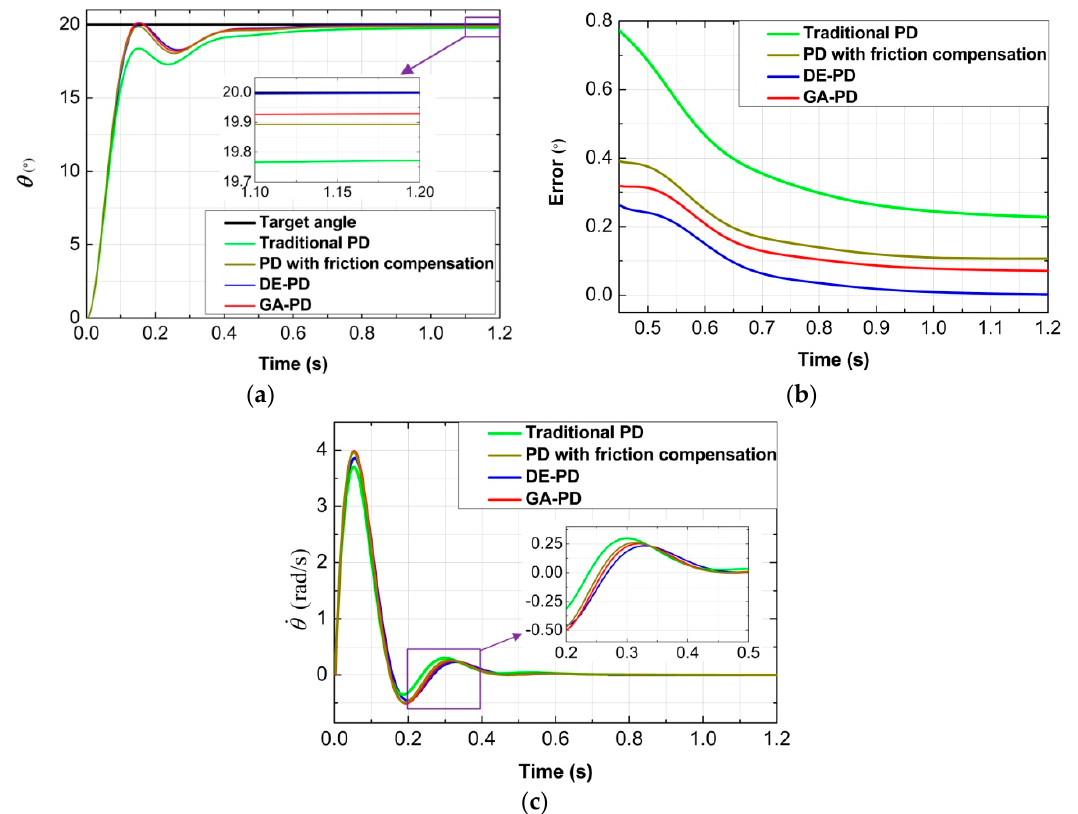
Figure 14. Position tracking performances under four control strategies. ( a ) Angle contrast curve; ( b ) error contrast curve; and ( c ) angular velocity contrast curve.